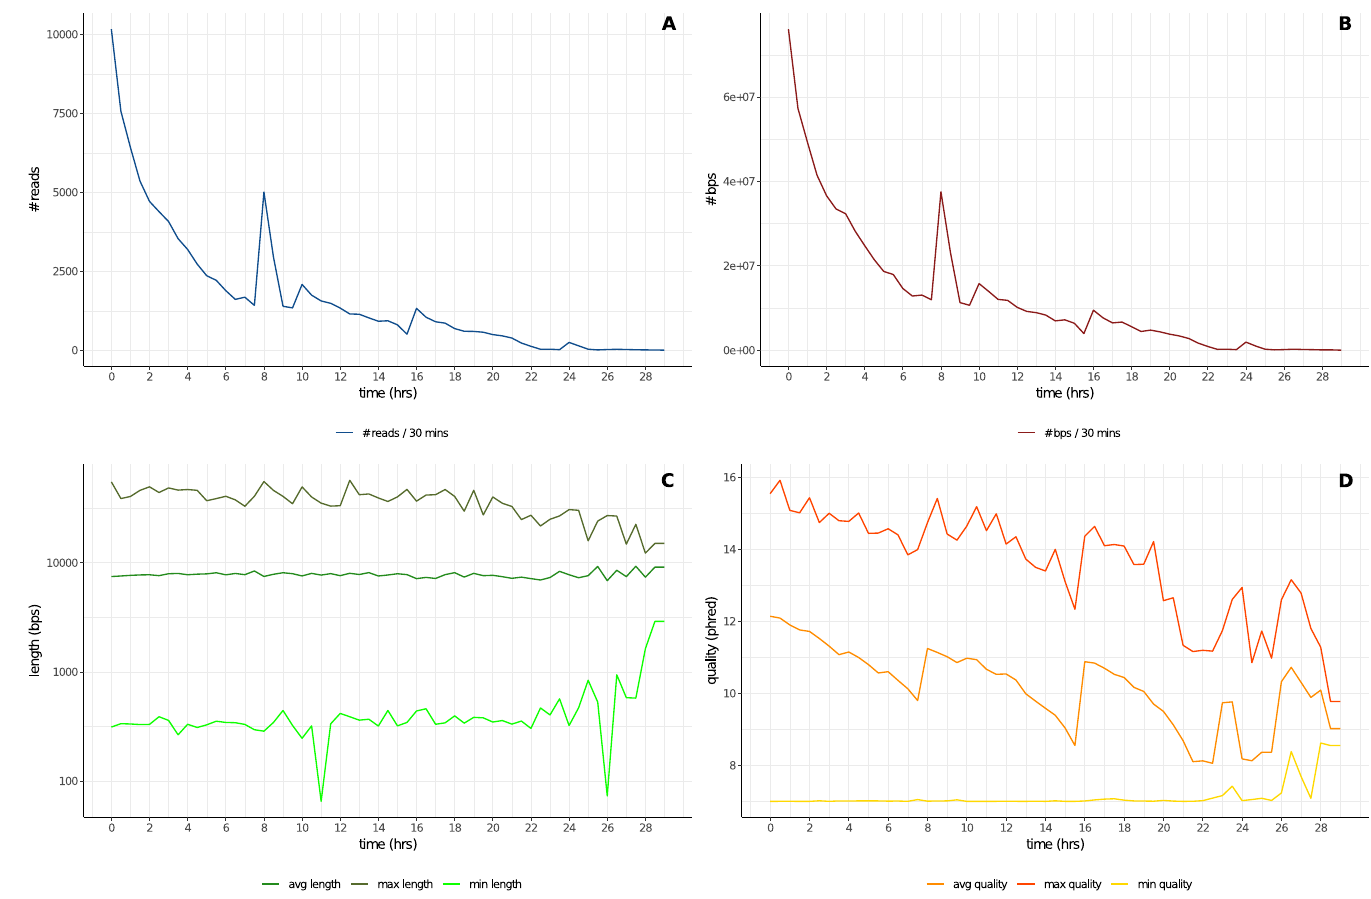
Fig 2. Reads number, base pairs number, reads length and reads quality per-time bin. The plots show the number of reads ( Panel A ) and basepairs ( Panel B ), the maximum, average and minimum length of reads in log 10 scale ( Panel C ) and the maximum, average and minimum quality of reads ( Panel D ), all calculated every 30 minutes of an experimental MinION